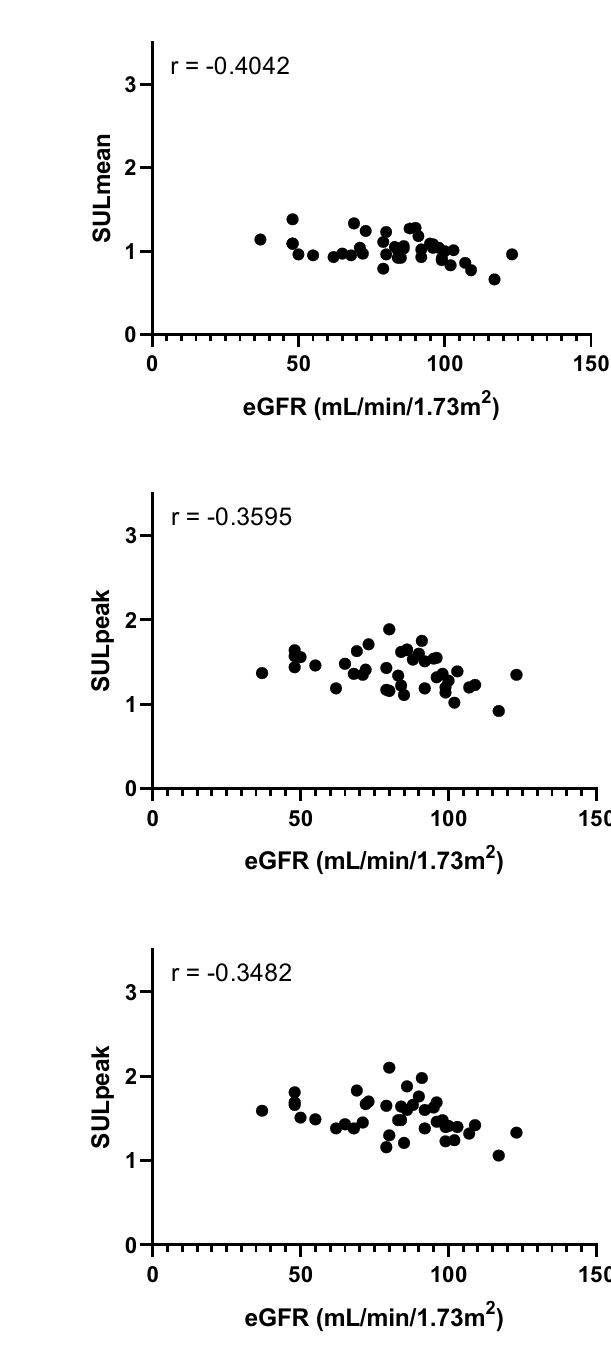
Figure 6. Plots of the estimated glomerular filtration rate (eGFR) and blood pool activity as measured by the mean standardized uptake value (SUV mean ), peak standardized uptake value (SUV peak ), maximum standardized uptake value (SUV max ), mean standardized uptake value corrected for lean body mass (SUL mean ), peak standardized uptake value corrected for lean body mass (SUL peak ), and maximum standardized uptake value corrected for lean body mass (SUL max ). Pearson’s r values are shown in the upper left corners, with p = 0.009 (SUV mean ), p = 0.035 (SUL mean ), p = 0.024 (SUV peak ), p = 0.042 (SUL peak ), p = 0.042 (SUV max ), p = 0.026 (SUL max ).